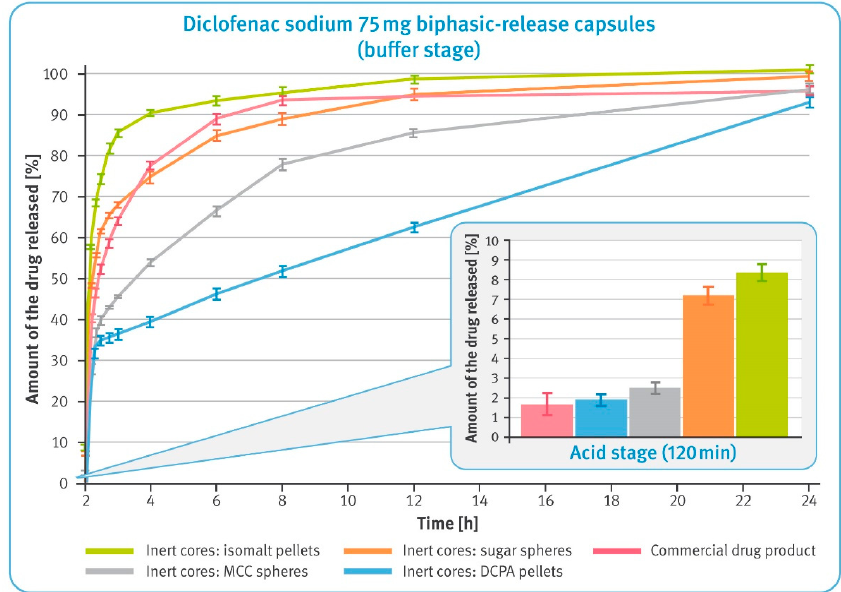
Figure 6. The release of the drug substance from diclofenac sodium 75 mg biphasic-released hard gelatin capsules in the acid phase, after 2 h incubation in 0.1 M HCl (in the smaller box) and in the buffer phase (phosphate buffer solution, pH 7.5) (mean of n = 6, SD is indicated by the error bars).